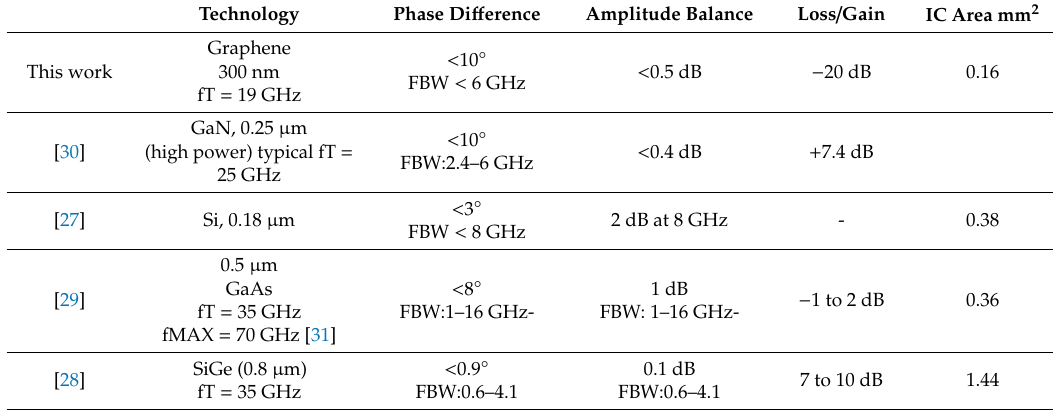
Table 1. Broad-band active balun state of the art, FBW = frequency